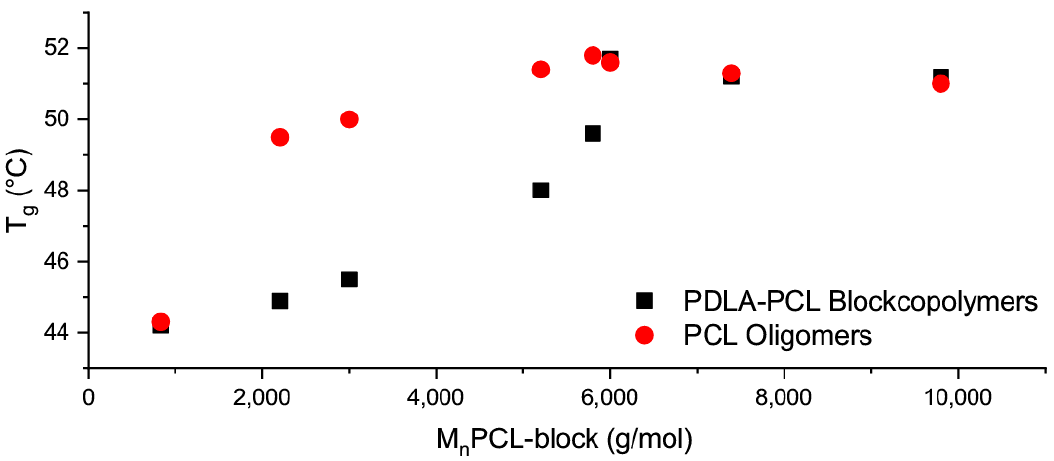
Figure 5. Dependence of glass transition temperature on molecular weight of PCL chains for blends of PLLA with PCL oligomers (red) and PLLA and PDLA-b-PCL block copolymers (black).